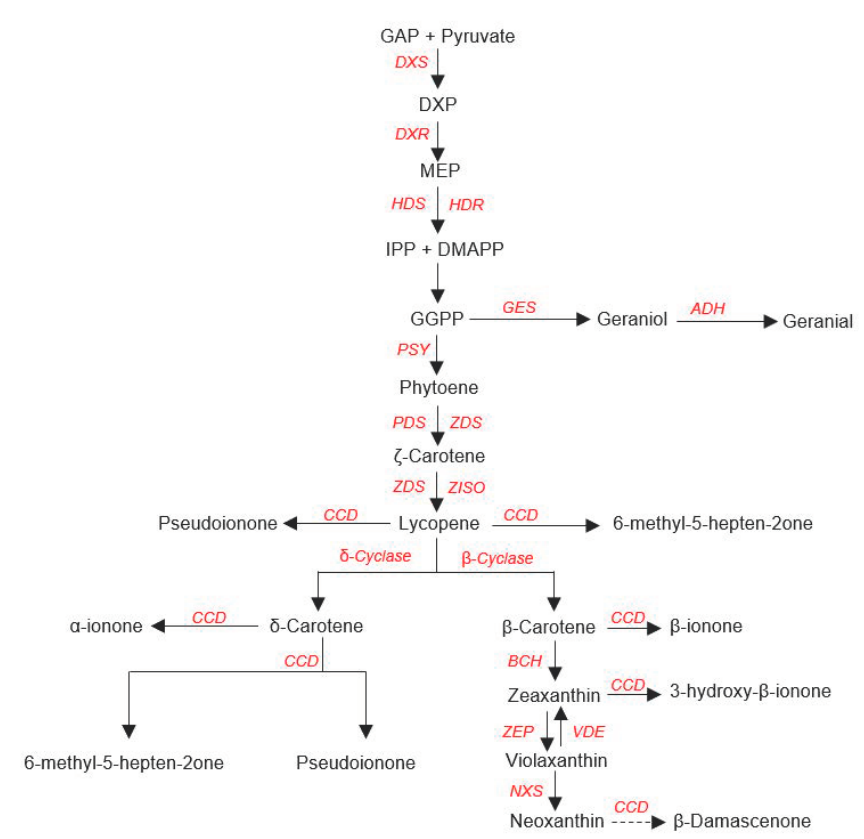
Figure 4. Overview of the carotenoid VOCs pathway, adapted from [135,141,142].